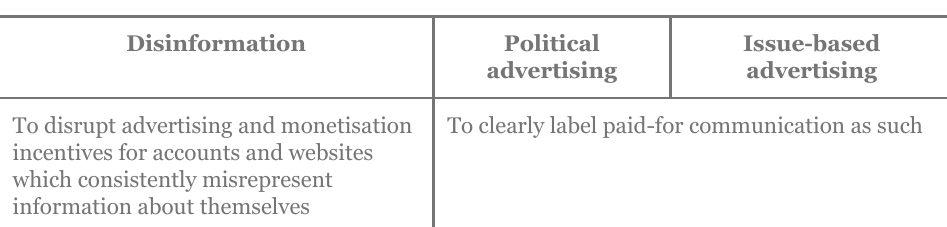
Table 1: Commitments of the signatories of the Code of Practice on Online Disinformation selected and grouped under three categories: disinformation, political advertising, issue-based advertising. Source: composed by the author based on the Code of Practice on